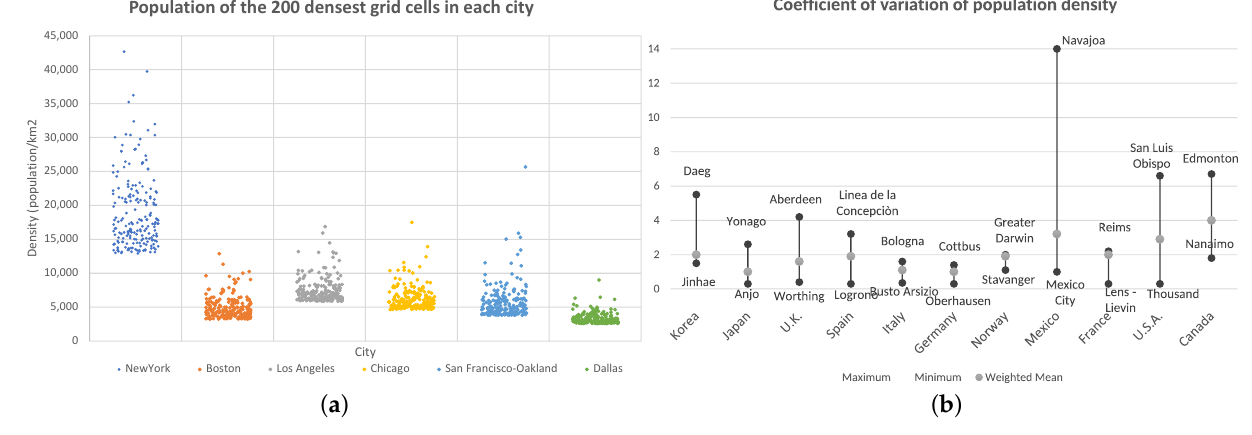
Figure 1. Intra-city and inter-city population densities in metropolitan urban areas. ( a ) Population densities of the densest 200 cells for a given set of cities. Each cell has a 1 km 2 area [17]. ( b ) Coefficient of variation of population density across urban areas and countries (2014) [16]. For each country, the gray dot is the average computed on the coefficient of variation of each city of the country. The figure also displays, for each country, the minimum and the maximum coefficients of variation, and the cities where they